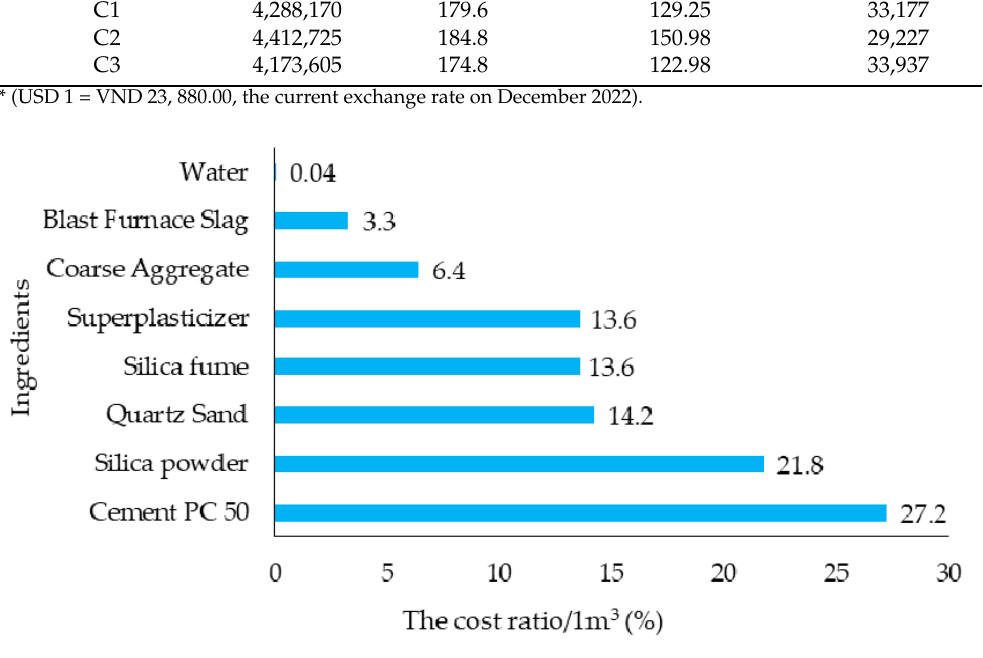
Figure 17. The cost ratio of the components in 1 m 3 of concrete (C2 sample).